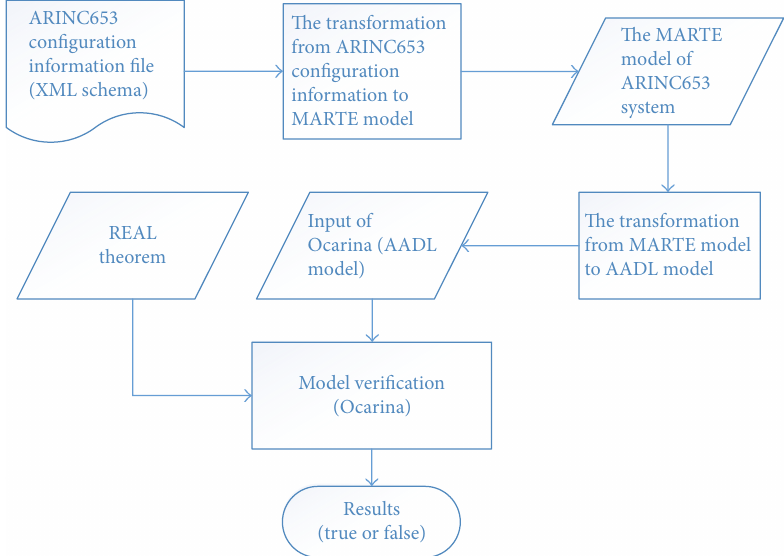
Figure 10: Validation framework of con fi guration